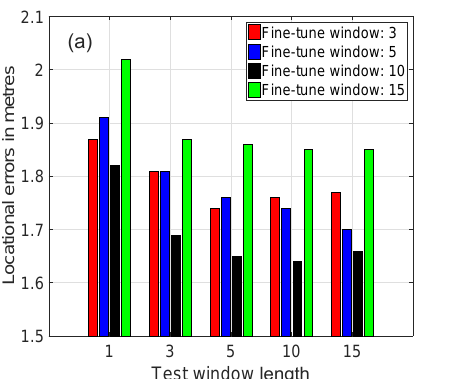
Figure 8. The effects of window length on the ( a ) location errors and ( b ) rotation errors for networks fine-tuned using Gradmag-Syn-car dataset and tested on gradmag of real